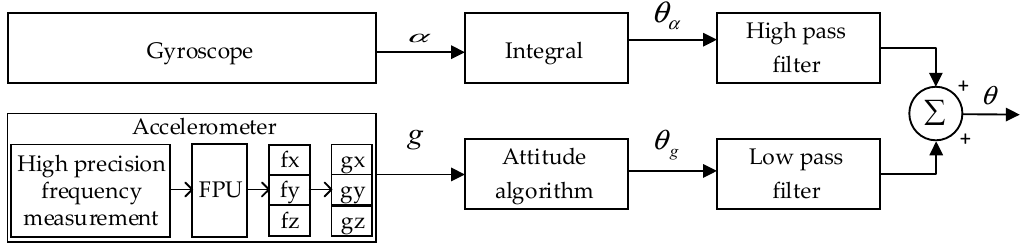
Figure 9. Complementary filtering principle diagram.